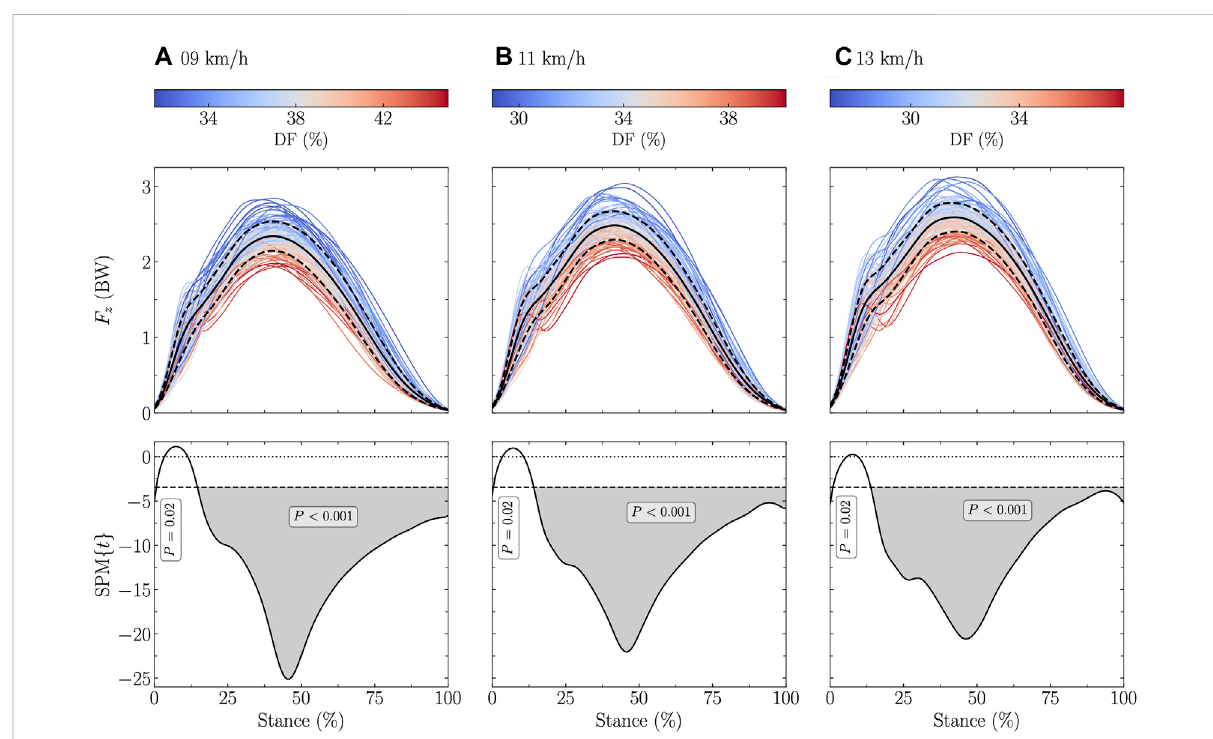
FIGURE 1 Statistical parametric mapping (SPM) analysis, i.e., t-statistics (SPM{t}), of the linear relationship between the vertical ground reaction force (F z ) andthedutyfactor(DF)alongtherunningstancephaseat (A) 9 km/h, (B) 11 km/h,and (C) 13 km/h.Intheupperpanels,F z ,expressedinbodyweight (BW),isdepictedforeachparticipant(thecolordependsontheDFvalue)andforthemean(blackline)±standarddeviation(dashedblackline)overall participants. In the lower panels, the black dashed horizontal lines represent the critical (parametric) threshold while the portion of the running stance phase which is statistically signi fi cant ( p ≤ 0.017; Bonferroni correction was applied to take into the three tested speeds) is given by the gray shaded